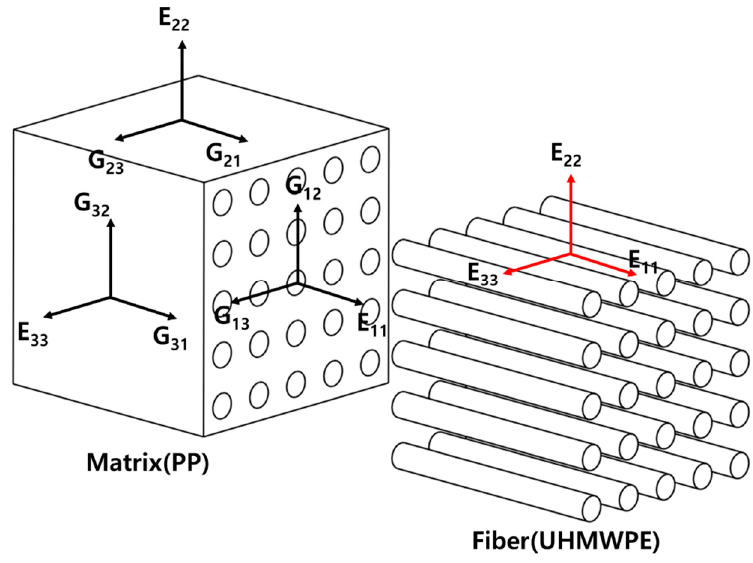
Figure 1. Tensor notation of fiber-reinforced composite materials.